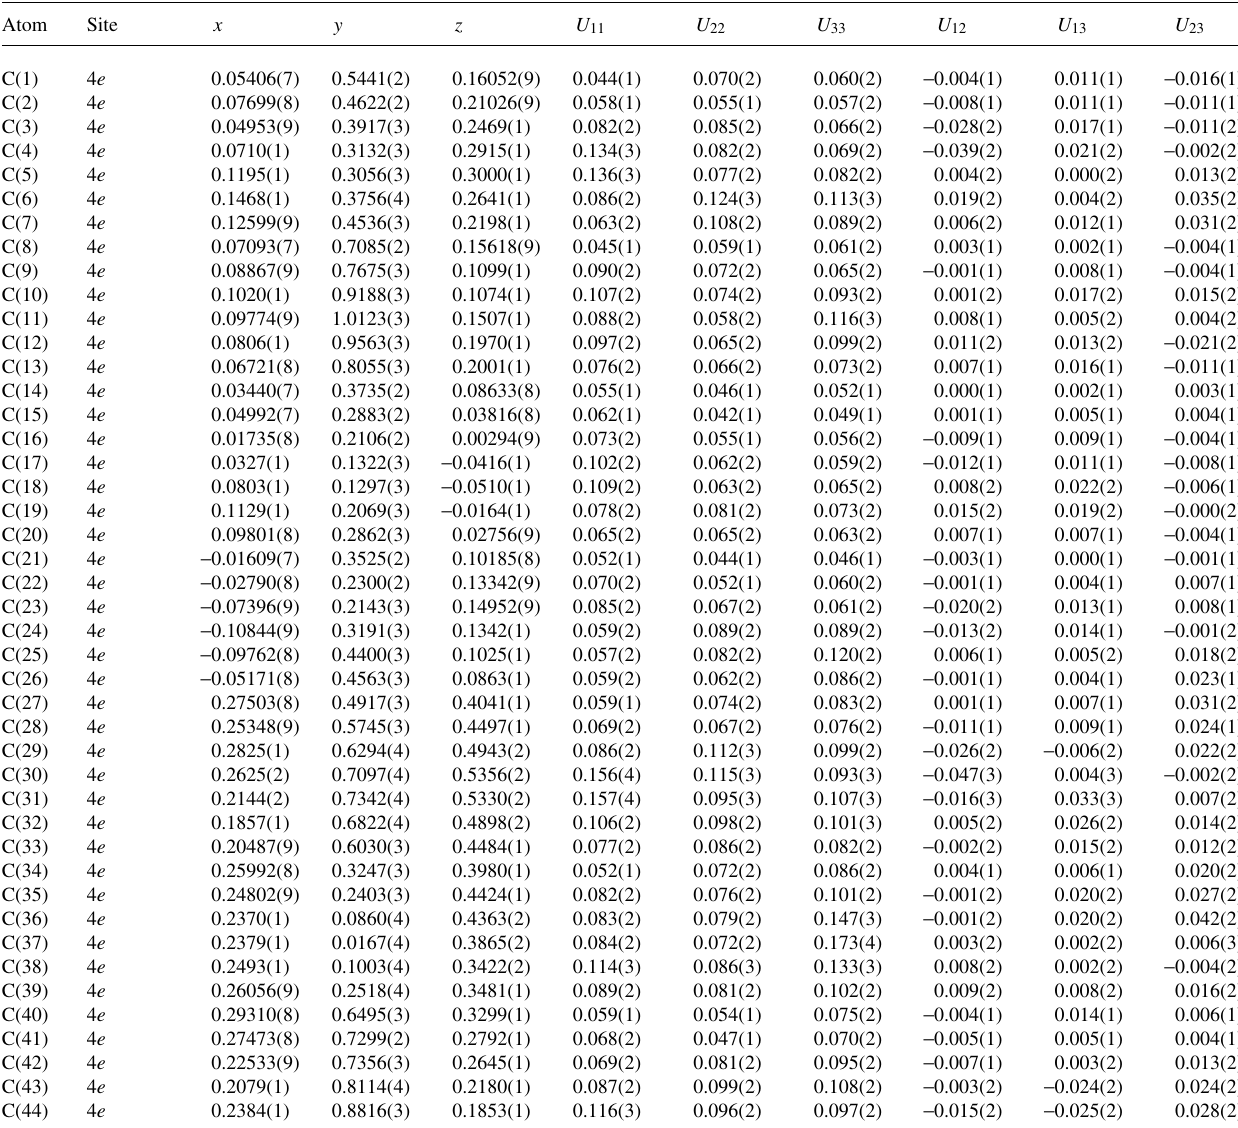
Table 3. Atomic coordinates and displacement parameters (in Å 2 )